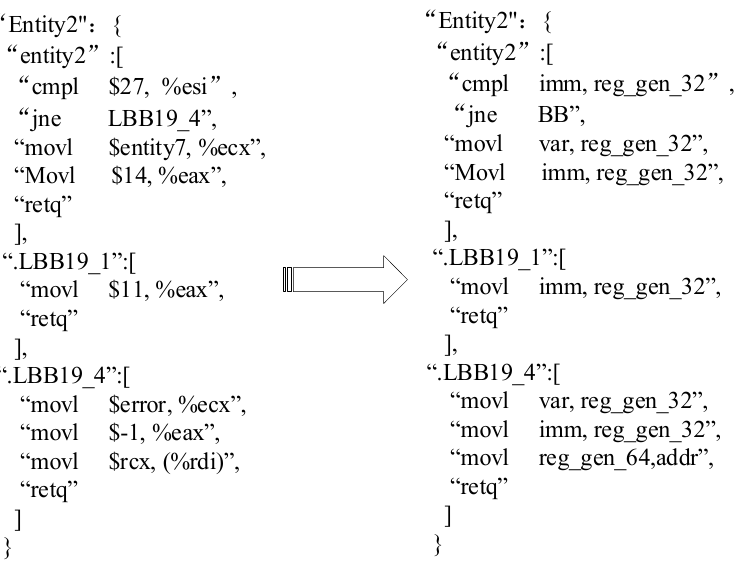
Figure 4. Schematic of normalization on function Entity2.